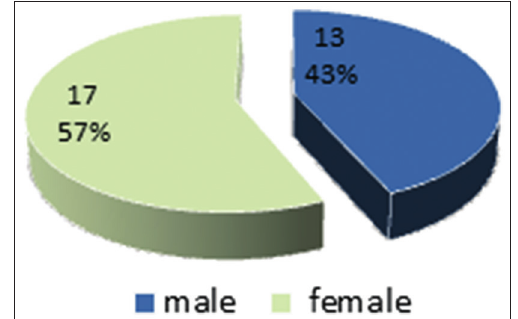
FIGURE 2. Sex structure of the treated patients